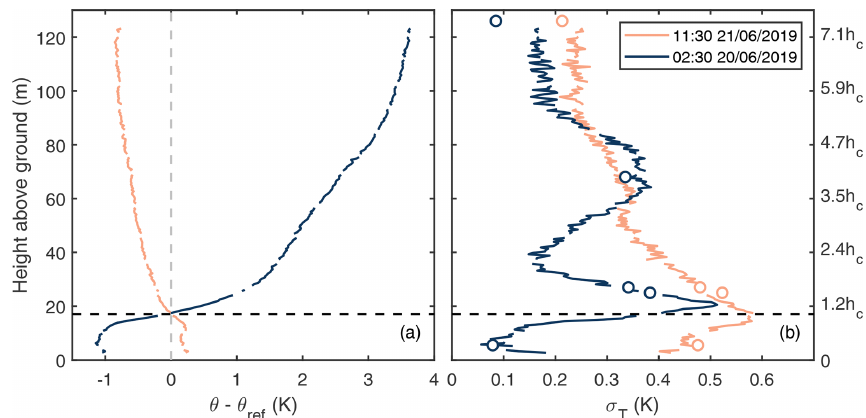
Figure 9. Mean potential temperature gradient (a) and standard deviation (b) profiles for the two example periods shown in Figs. 8 and 10. Dots in panel (b) show the σ T values estimated with the 3D sonic anemometers at different heights.